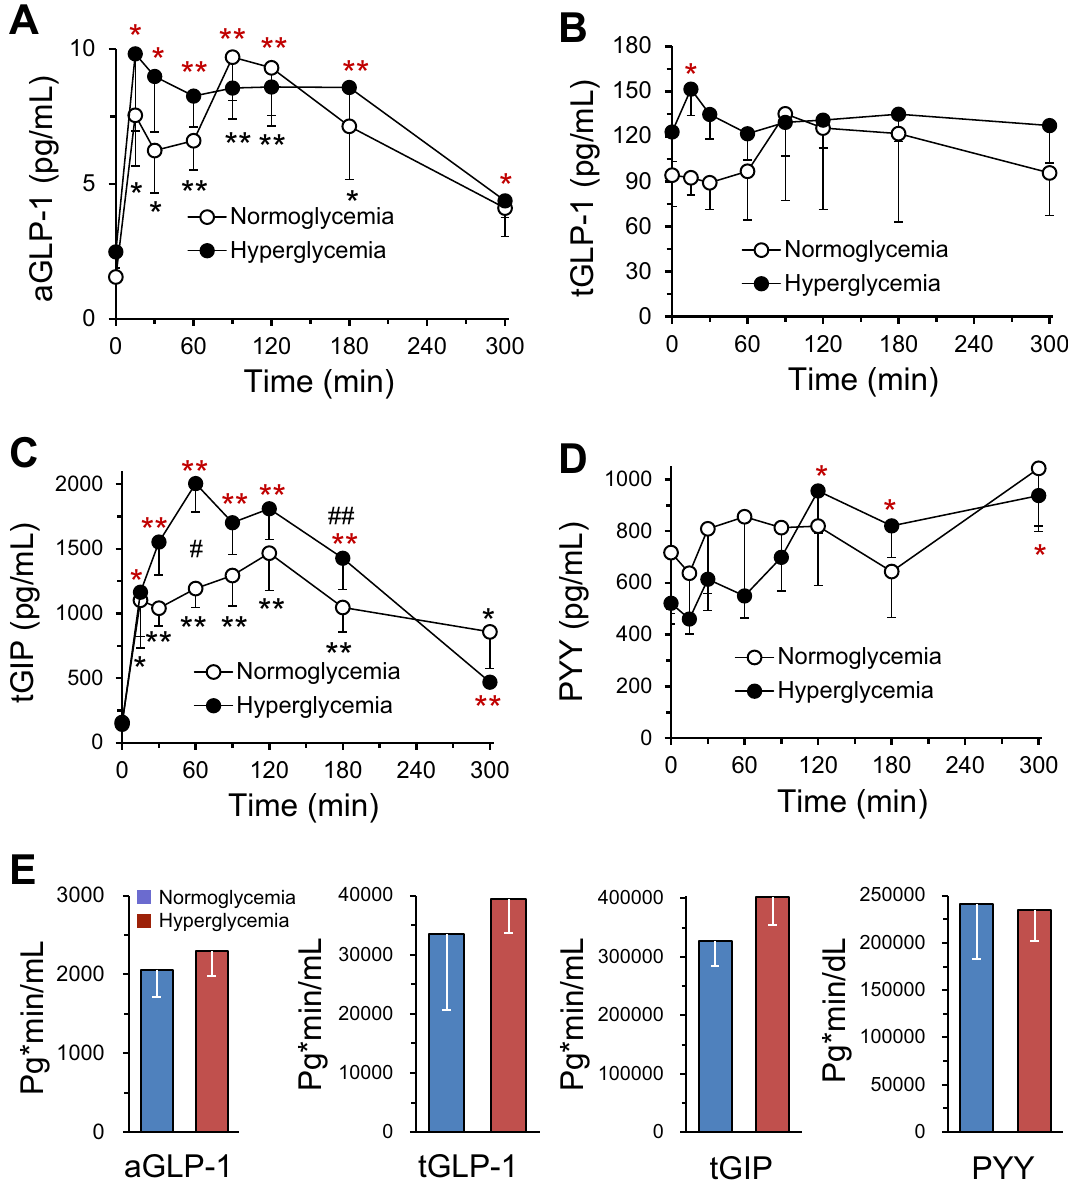
Figure 7. Time course for changes in plasma aGLP-1 ( A ), tGLP-1 ( B ), tGIP ( C ) and PYY ( D ) concentrations following nasogastric meal administration immediately after the time of 0 min (baseline) in normoglycemic (n = 5) and hyperglycemic (n = 11) monkeys. ( E ) Shows the corresponding total AUCs of plasma aGLP-1 in ( A ), tGLP-1 in ( B ), tGIP in ( C ) and PYY in ( D ) of the MMTTs. These AUCs did not show significant differences ( p > 0.05) between normo- (* or **) and hyper-( * or ** ) glycemic groups. *, p < 0.05 or **, p < 0.01; vs the self- baseline at time 0 min. # p < 0.05 or ## p < 0.01; vs the normoglycemic